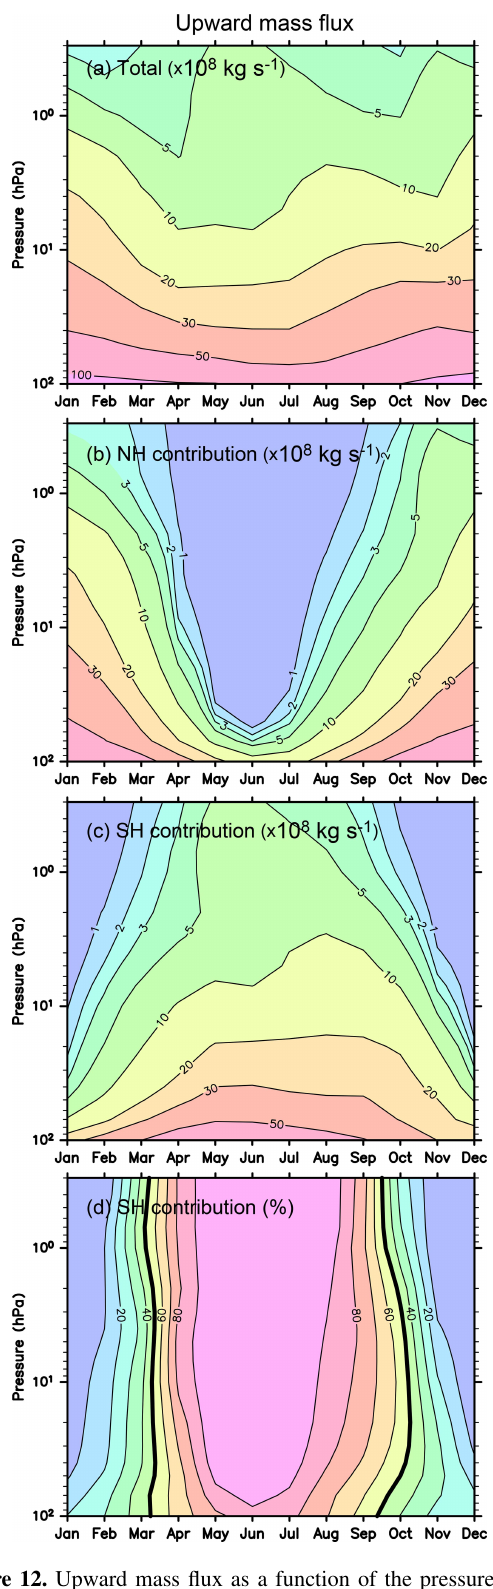
Figure 12. Upward mass flux as a function of the pressure level. (a) Total and contributions of the (b) NH and (c) SH. (d) The per- centage of the SH contribution to the total upward mass